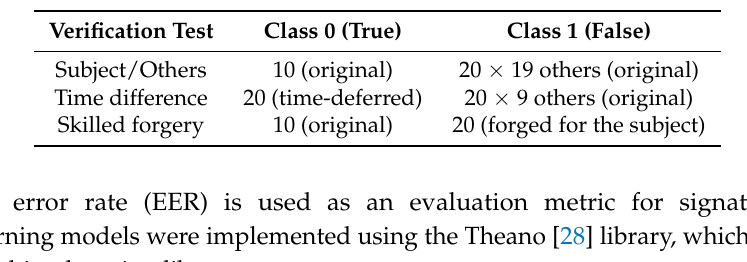
Table 2. Signature verification test data for each subject.